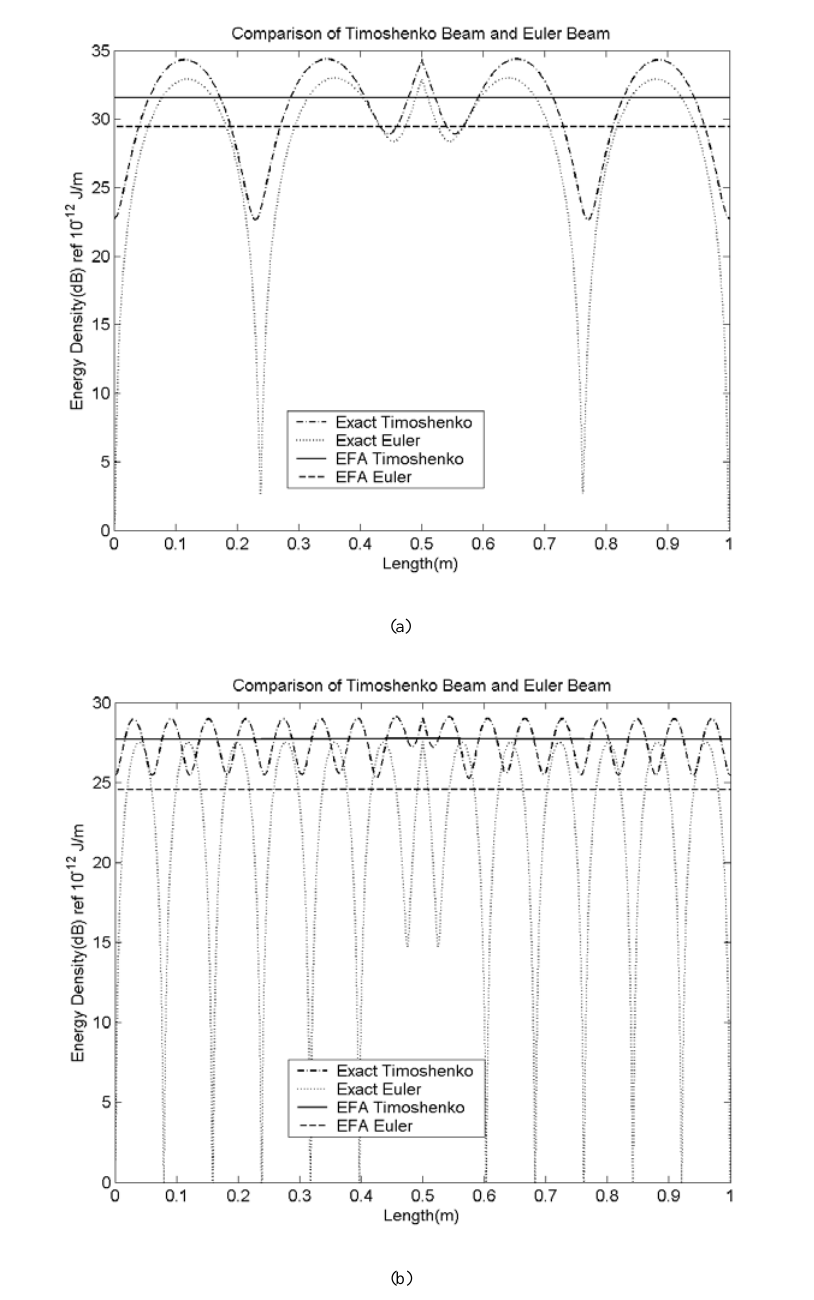
Fig. 8. The energy density level distributions of the Timoshenko beam ( L / H = 20, f c = 31.7 kHz) when η = 0.01. The reference energy density is 10 − 12 J/m: (a) f = 2 kHz, (b) f = 18 kHz, (c) f = 70 kHz, (d) f = 130 kHz: - · - · -, classical solution of the Timoshenko beam; ····· , classical solution of the Euler-Bernoulli beam, —, EFA solution of the Timoshenko beam; ---, EFA solution of the Euler-Bernoulli beam.